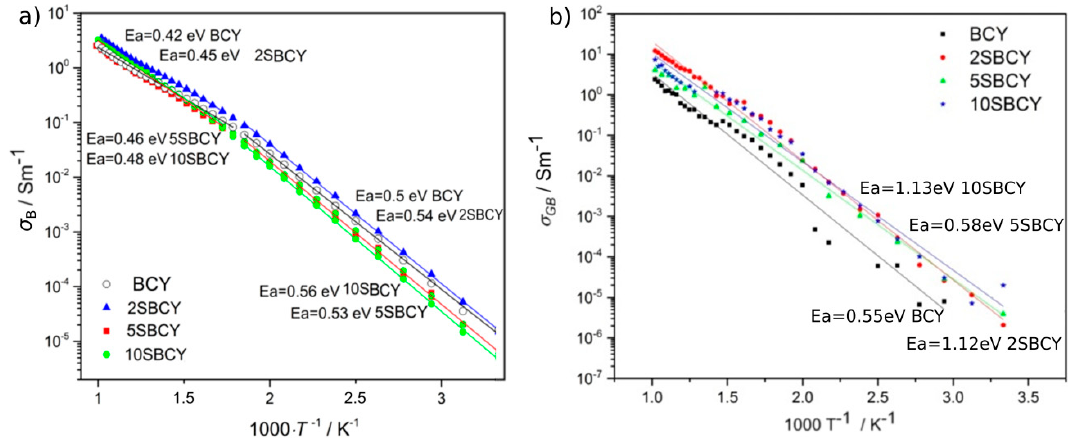
Figure 10. Variation in grain interior σ B ( a ) and grain boundary σ GB ( b ) conductivities of the SBCY sample series vs sample series vs temperature.